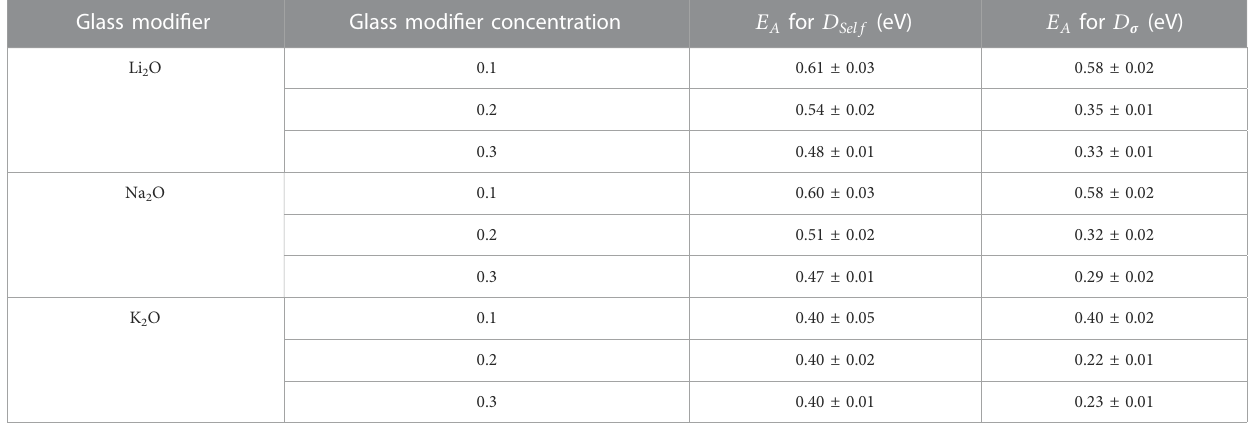
TABLE 4 Activation energies obtained using linear fi ts from the average values for D Self and D σ shown in Figure 4 ( R 2 ≥ 0.95) and Eq. 6. Errors presented were obtained from the mathematical fi t (OriginPro 2019). Glass modi fi